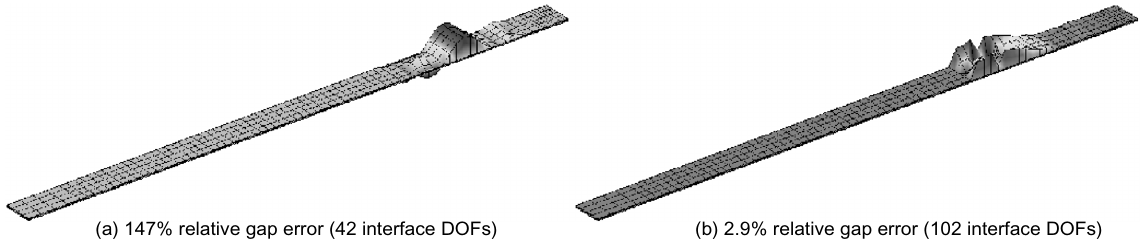
Fig. 5. Absolute gap error g − g ref (individually normalized) visualized as vertical displacements on the contact area of the FE model of the beam substructure (damper not shown, displacements outside of contact surface are set to 0).